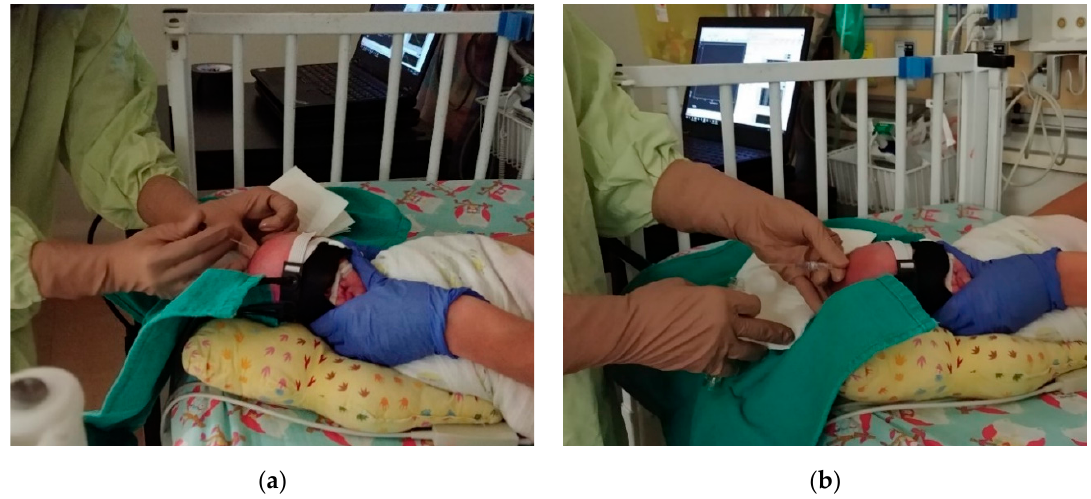
Figure 2. ( a ) Pediatric neurosurgeon inserting a needle into the ventricle and ( b ) draining cerebral spinal fluid (CSF) from the patient. Optical probes were affixed to the patient’s head throughout the procedure.